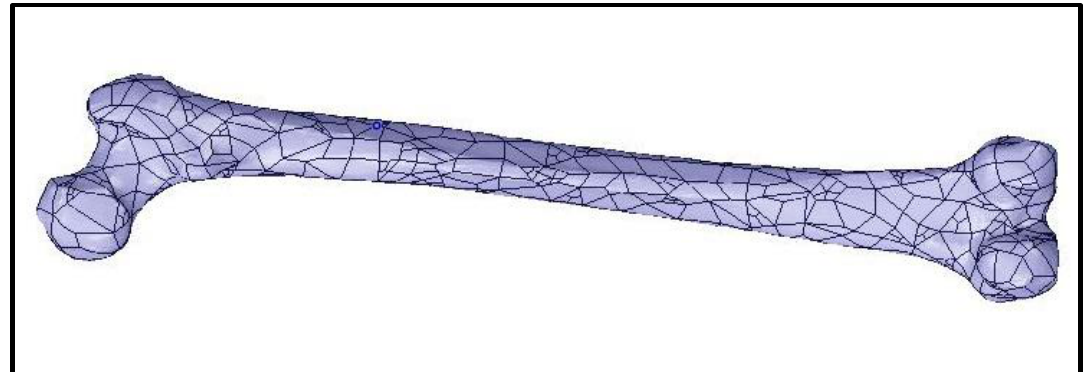
Figure 4. Femur model with a subtrochanteric fracture ( left ), intertrochanteric fracture ( middle ), and intracapsular fracture ( right ). Reprinted from Ref. [21]. 2.3. Finite Element Analysis The models of the intramedullary nail, helical screw, cortical screws, and femoral bones were imported into ANSYS Workbench 2022 R1 for simulation. Before the simula- tion, the material properties were assigned to the intramedullary nail and the screws, and boundary conditions were assigned to all models. The material properties of the device parts were assigned as those of the titanium alloys Ti-15Mo for the CM nail and Ti-6Al- 7Nb for the screws, as per ASTM F2066-18 and ASTM F1295-05 standards [23 – 25]. For the simplified femur models, the cortical and cancellous parts were assigned a modulus of elasticity of 12.7 GPa and 0.9 GPa and a Poisson ’ s ratio of 0.3 and 0.2, respectively [26 – 29]. The intramedullary nail, the helical screw, and the two cortical screws were posi- tioned within the femur model, with the helical screw aligned along the femoral neck and its tip near the centre of the femoral head (Figure 5). The axis of the helical screw model was configured to match the axis of the cylindrical shaft in the CM nail, and the long body of the nail was positioned as close to the centre of the long part of the femur as possible without affecting the other boundary relationships. The intracapsular and intertrochan- teric fractures in the femur were divided along their fracture surfaces to allow for the ad- dition of friction coefficients between the fractured parts of the bone. With the geometry established, the numerical simulation of the finite element analysis could proceed.